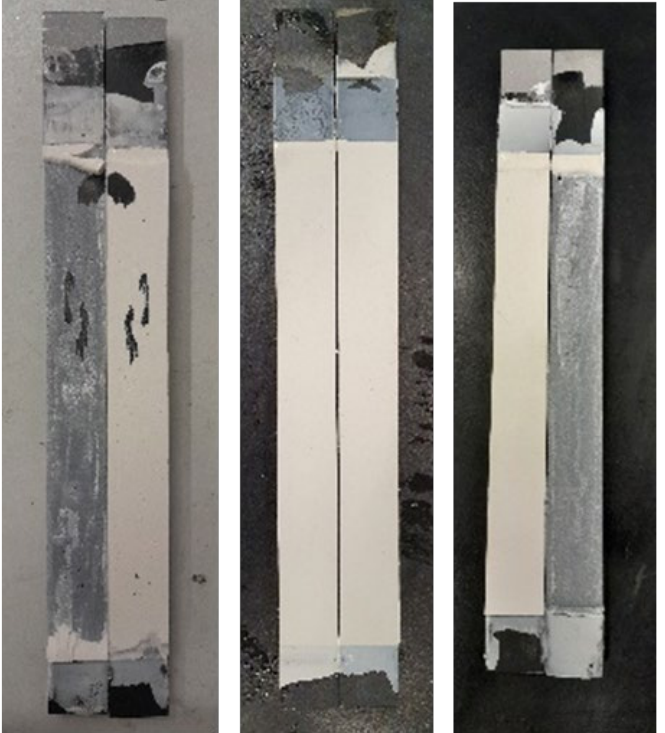
Figure 11. Fracture surfaces obtained under intermediate loading rate (200 mm/min) at, respectively, 23 ◦ C ( left ), − 30 ◦ C ( middle ), and 60 ◦ C ( right ).